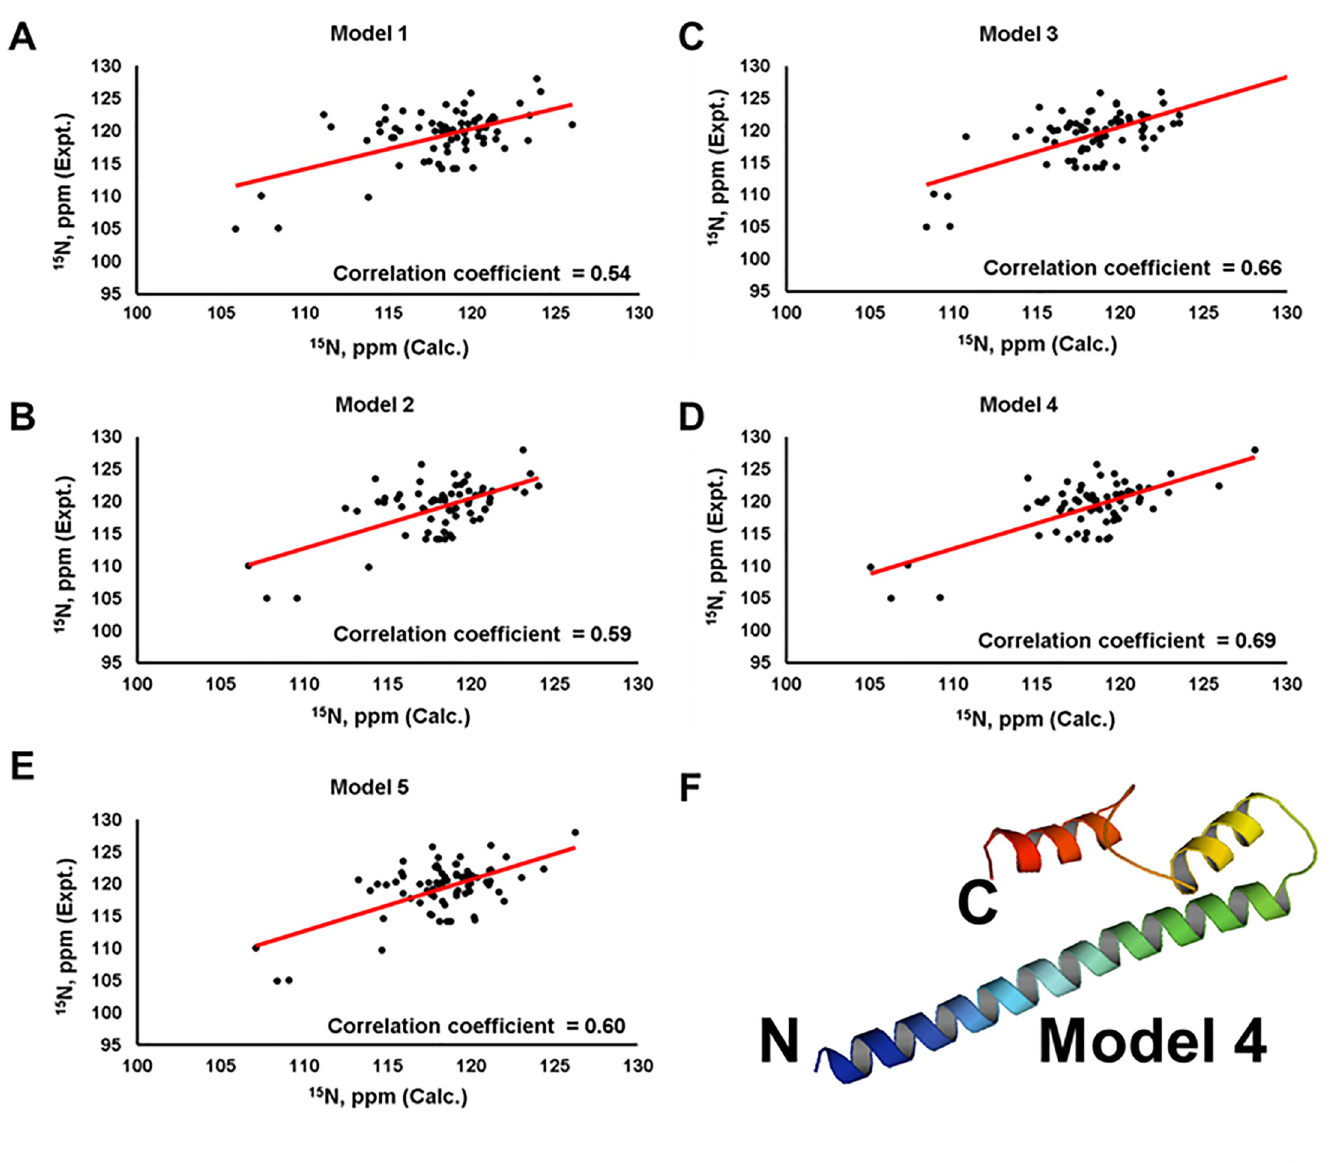
Fig 5. In silico modeling of the C-terminal domain of EB3 based on the structure of EB1 alone (PDB ID: 3GJO) provides an additional plausible conformation. A-E ) Comparisons of experimental 15 N chemical shifts for the C-terminal domain of EB3 plotted along the Y-axis with the corresponding 15 N chemical shifts calculated by SHIFTX 2.0 plotted along the X-axis; correlation coefficients are shown for each comparison. ( F ) Model 4 exhibits the highest R 2 correlation coefficient of 0.69 for experimental versus calculated 15 N chemical shifts. N- and C-termini are marked. ( Fig 5 ), secondary structure restraints alone ( S1 Fig ), or without either EB1 homology or sec- ondary structure information ( S2 Fig ). The best models based on the structure of EB1 with and without NMR-derived secondary structure restraints had comparable correlation coeffi- cients of 0.68 and 0.69 for the predicted versus experimental 15 N chemical shifts, respectively ( Figs 4 & 5 ), while removing EB1 homology restraints reduced these correlations ( S1 and S2 Figs ). This suggests that the structure of EB1 is essential for modelling plausible topology of the C-terminal domain of EB3.